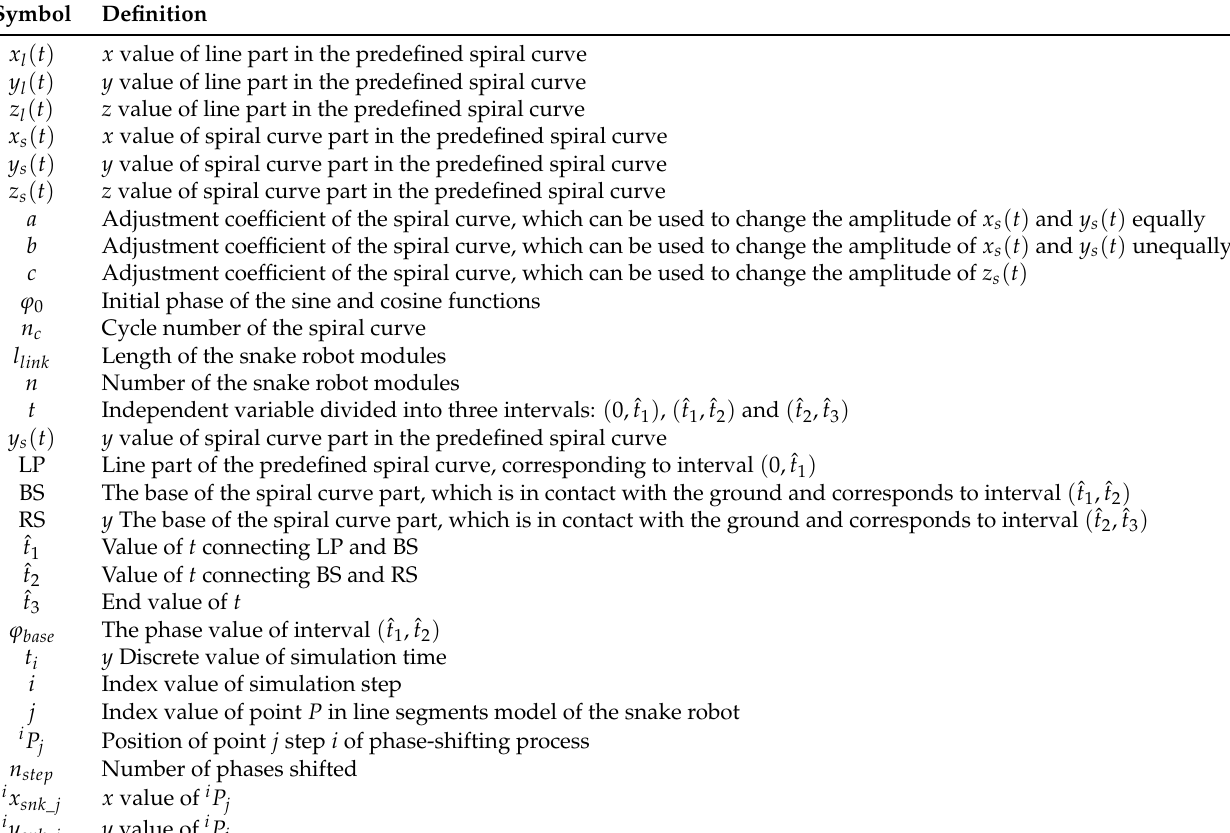
Table A1. Symbols utilized in this